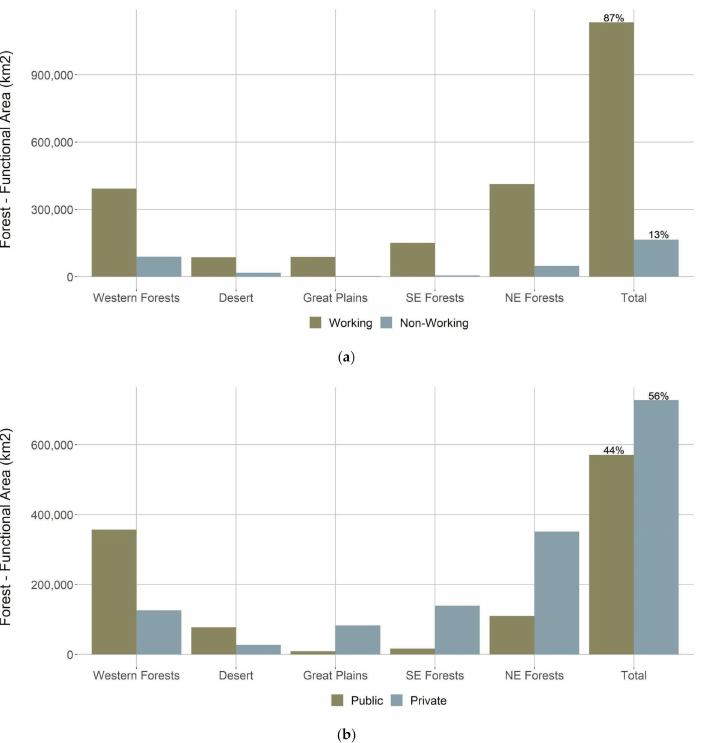
Figure 10. ( a ) The area of functional Forest Habitat on working vs. non-working lands by ecoregion. ( b ). The area of Functional Forest Habitat in Public vs. Private ownership by